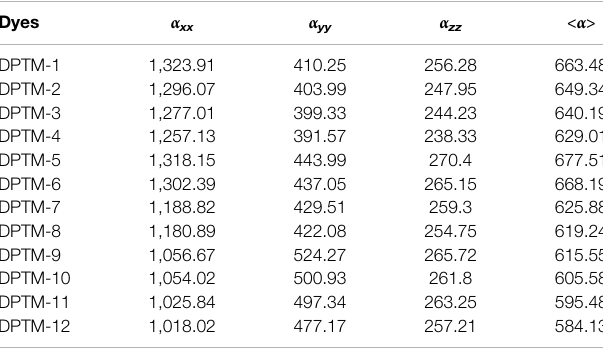
TABLE 4 | Dipole polarizabilities and major contributing tensors ( a.u .) of investigated compounds (DPTM-1 to DPTM-12).